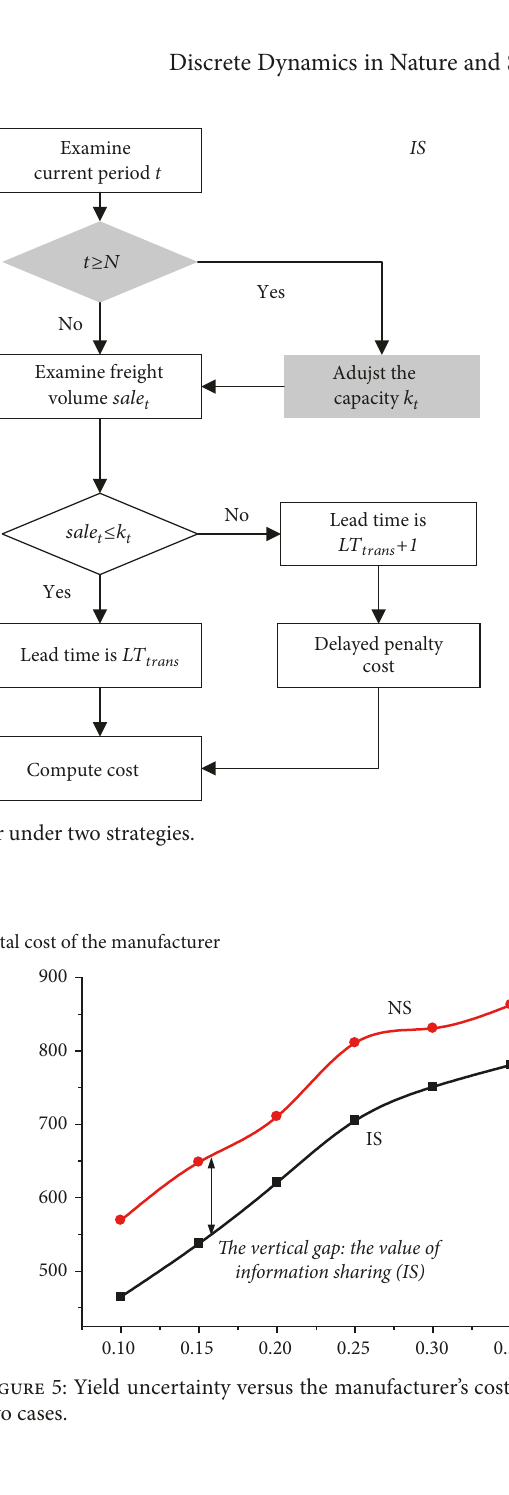
Figure 5: Yield uncertainty versus the manufacturer’s costs under two